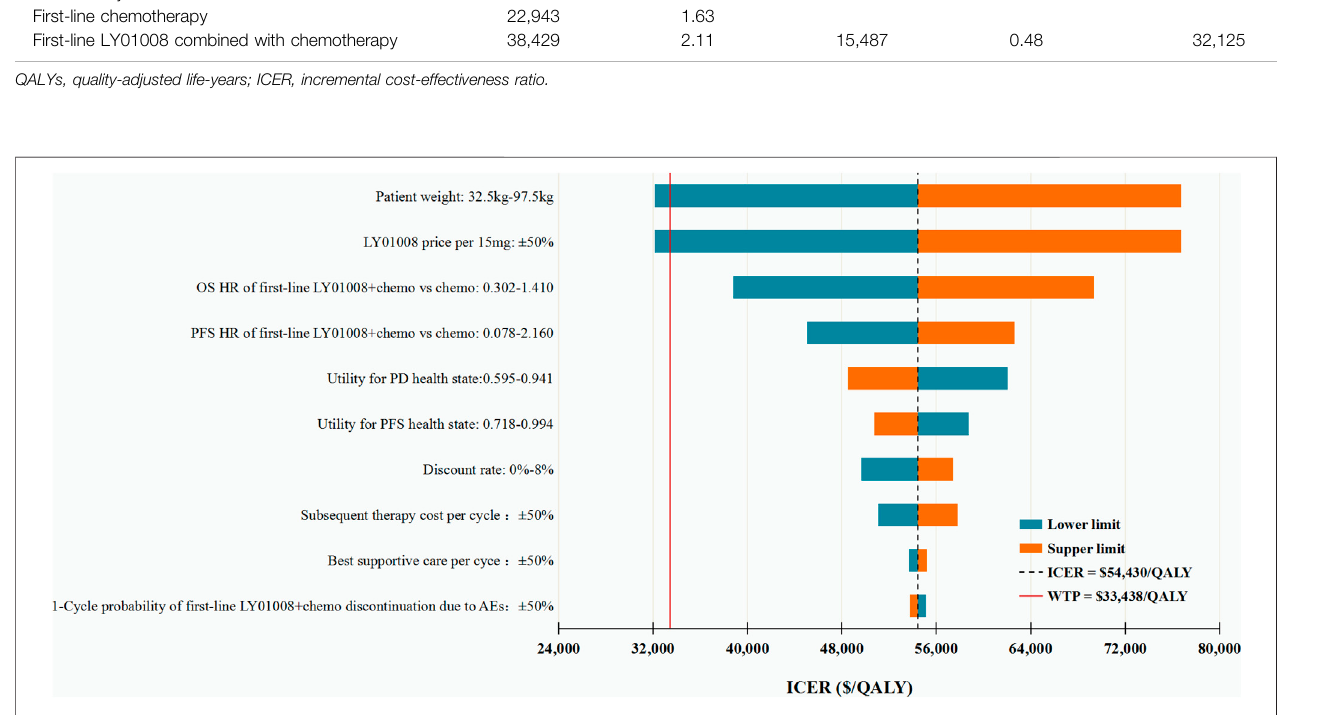
Frontiers in Pharmacology |